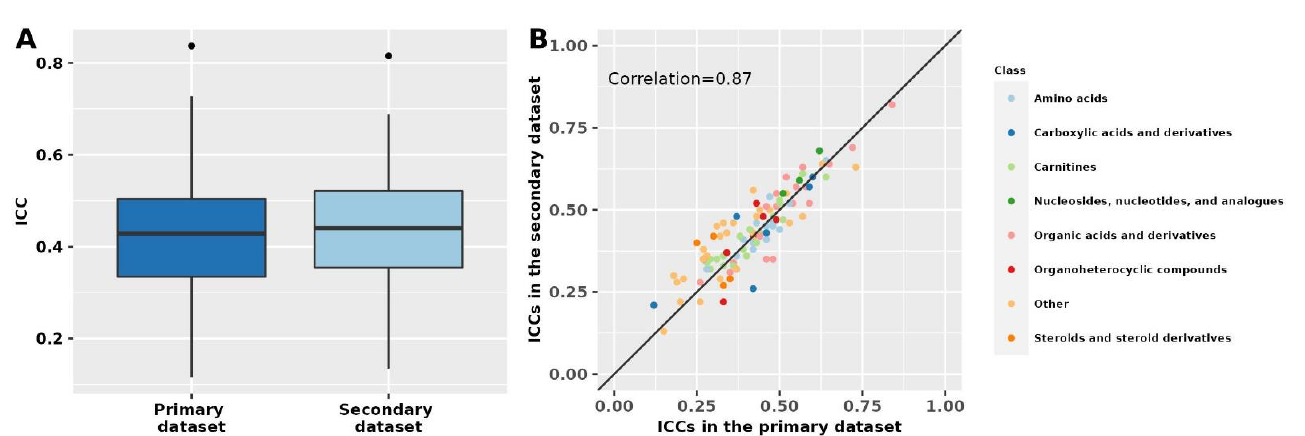
Figure 2. Metabolomics stability over 10 years in the primary and secondary datasets. The primary dataset was restricted to polar metabolites and fasting women to match the secondary dataset. Intra- class correlations (ICCs) in the two datasets are shown as boxplots (panel A ) and by metabolite class in a scatter plot (panel B ). The correlation was estimated using Spearman’s rank correlation coeffi- cient. In panel A , ICCs beyond the whiskers (outliers) are plotted individually as black dots. The lower whisker extends from the lower hinge of the box (25 th percentile) to the smallest value but no further than 1.5*IQR (inter-quartile range). The upper whisker extends from the upper hinge of the box (75 th percentile) to the largest value but no further than 1.5*IQR (inter-quartile range).